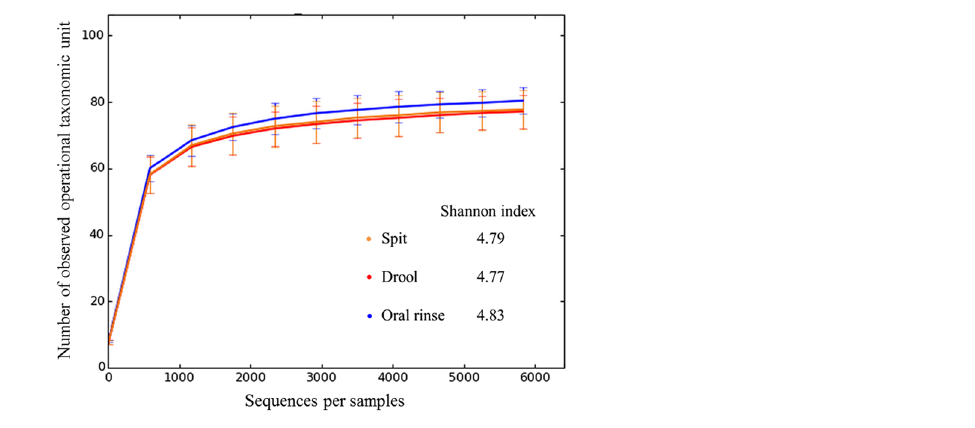
fractions were Streptococcus (17.5%), Prevotella (15.5%), Veillonella (15.3%), Neisseria (12.7%) and Haemophilus (10%). Calypso’s redundancy analysis was used to determine if combining the distribution pattern of all the genera from each saliva fraction into a panel could distinguish different saliva fractions (Fig. 7a). The p-value generated was 0.999, indicating that there are no significant differences. A second redundancy analysis under the same set of parameters was also carried out to investigate if the genera distribution of the three saliva fractions is distinguishable from one another (Fig. 7b). The results showed that the genera distributions from the three saliva fractions were significantly different for each individual with a p-value of 0.001, indicating the microbiome were more driven by host/environmental variations between subjects.